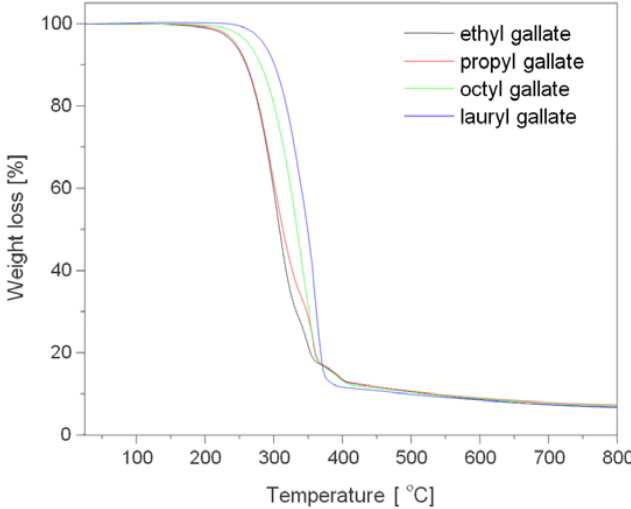
Figure 3. Thermal decomposition (TGA) curves of gallates.